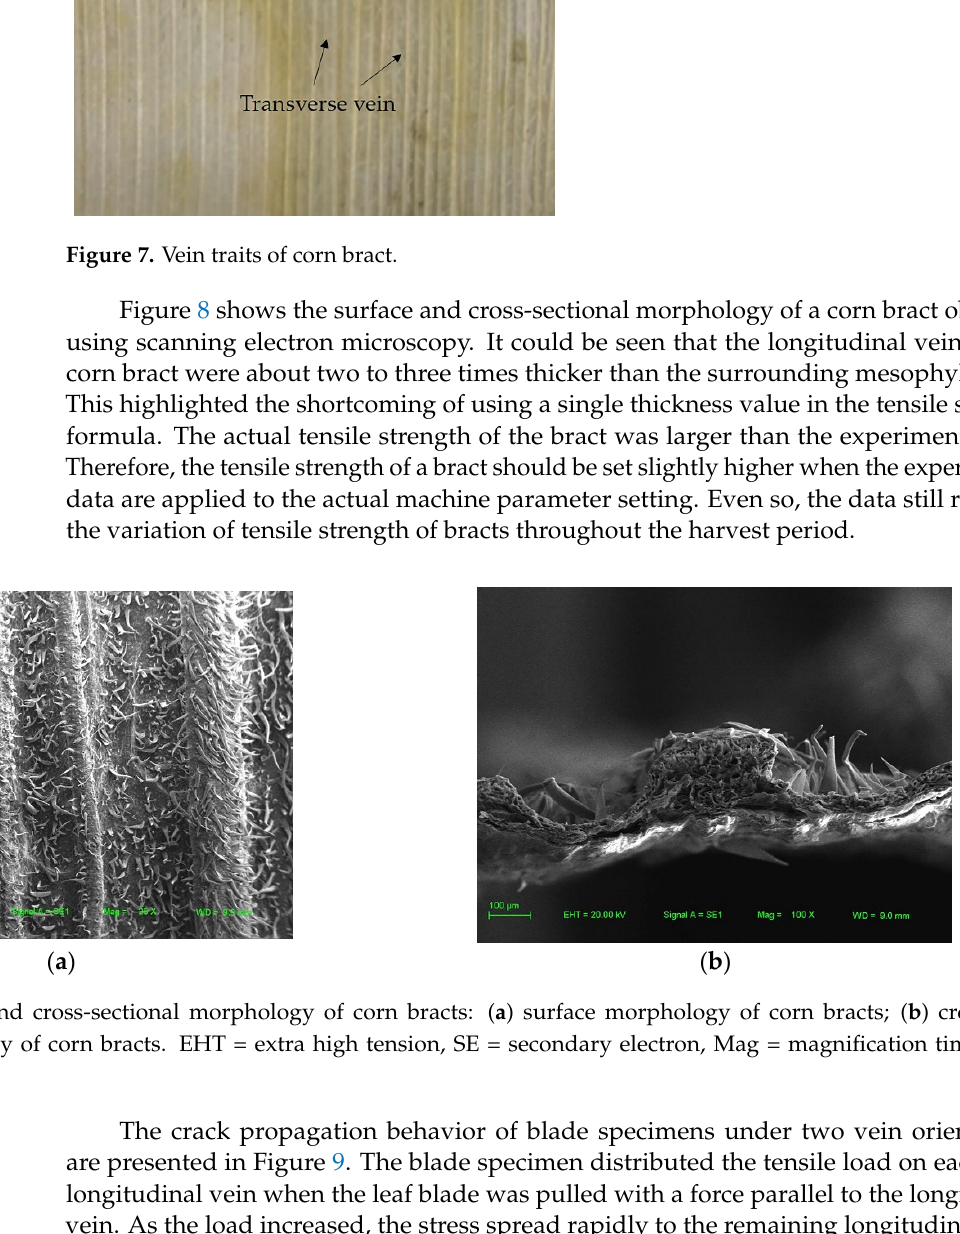
Figure 6. Relationships between tensile properties and sheath thickness: ( a ) fracture force; ( b ) tensile strength; ( c ) fracture energy.